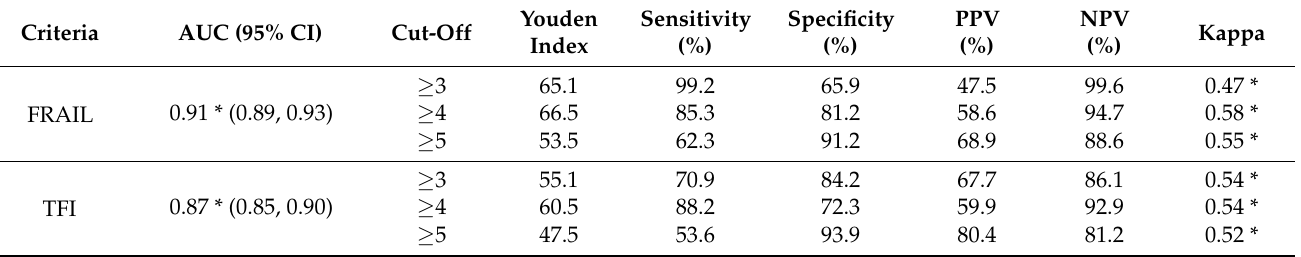
Table 4. Diagnostic accuracy of the CFSS-10 using the FRAIL scale, TFI and FI as criteria (sample